Question: Express in one sentence what the figure is showing.
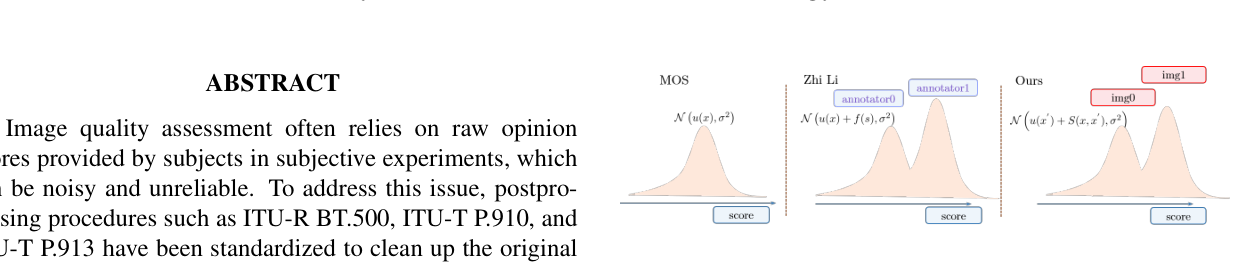
Answer: Left: traditional MOS model, Gaussian Distribution. Middle: model with annotator information added, Gaussian multimodal distribution. Right: model with image informa- tion added, Gaussian multimodal distribution. u(x) is re- garded as the true quality. f(s) is a learnable bias of anno- tator s. u(x ′) is regarded as the true quality of the reference image. S(x, x ′) represents the score residual converted from the perceptual similarity between images.